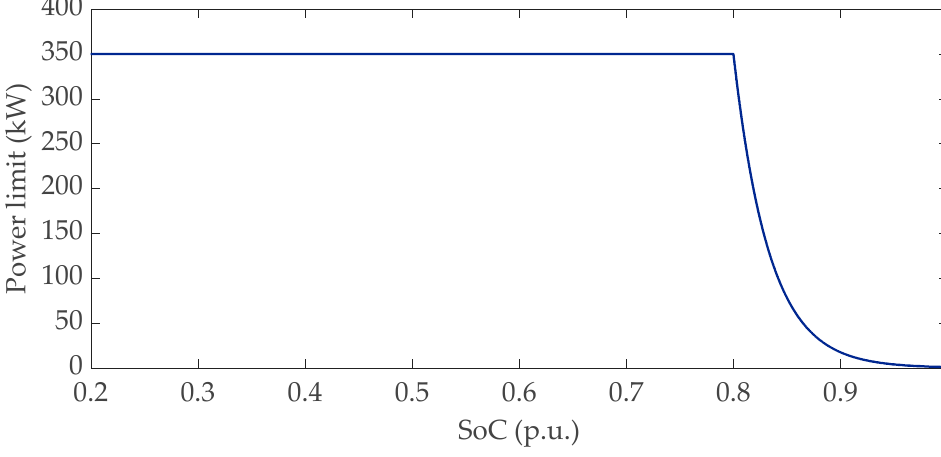
Figure 7. Profile of the limit of the charging power related to the SoC. Next, the results of the application of the proposed approach are reported and com- pared to those related to the uncontrolled case, which refers to the operation of the microgrid under study with the PEVs charged with the maximum power allowed, according to the curve in Figure 7. Thus, three case studies are